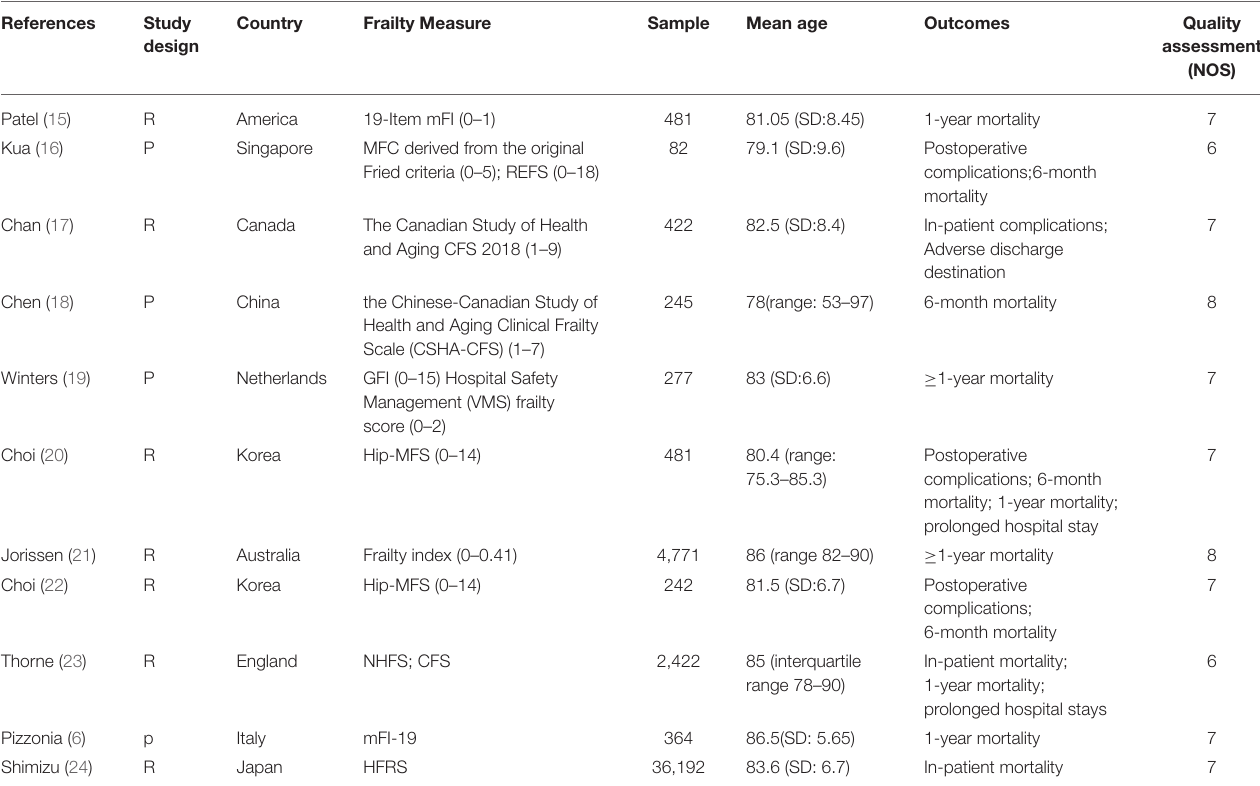
TABLE 1 | Characteristics of all the studies included in the